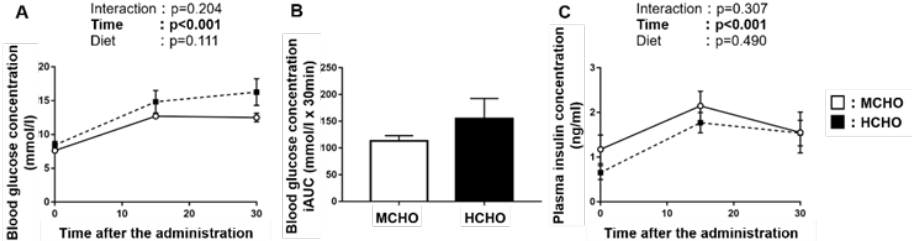
Figure 4. ( A ) Blood glucose, ( B ) the incremental area under the curve (iAUC) of blood glucose, and ( C ) plasma insulin concentrations after the post-exercise oral administration of the glucose solution (1.5 mg/g BW) in mice fed the HCHO (black; n = 7) or MCHO (white; n = 7) diet. Values are mean ± SE.